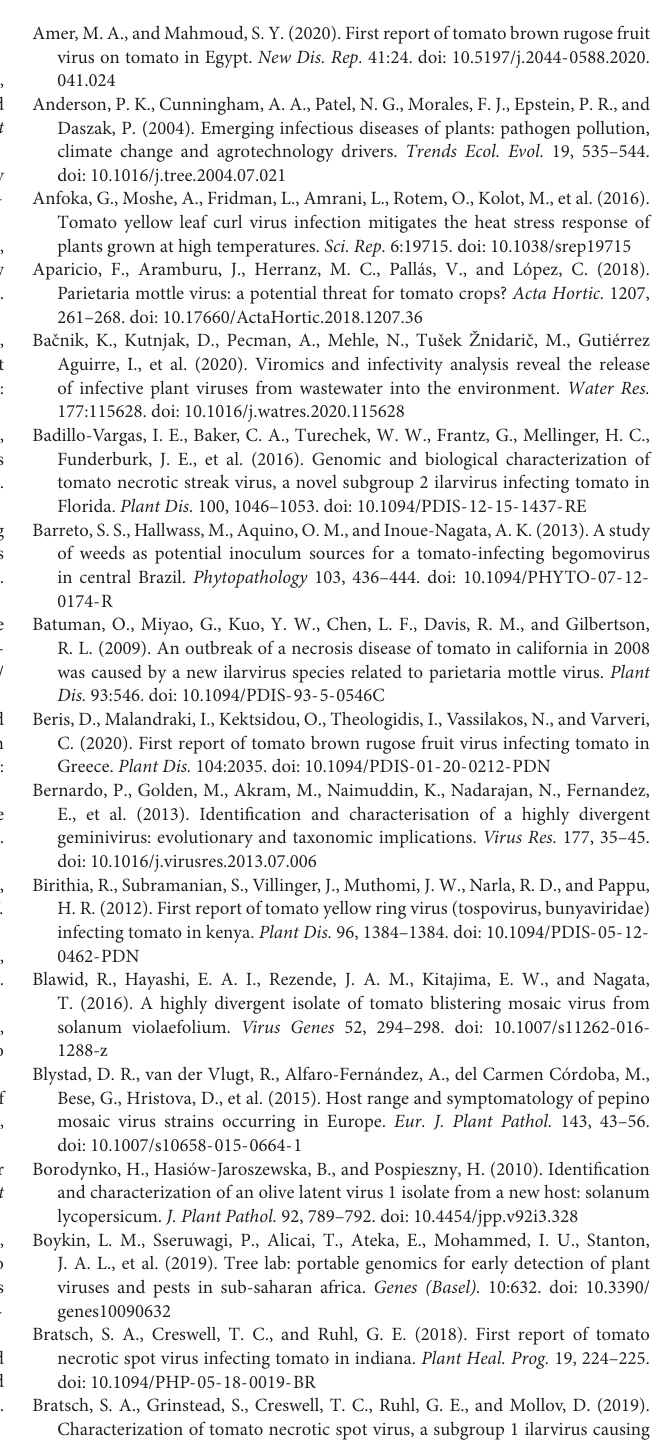
Supplementary Table 2 | Summary list of all viruses with tomato indicated as host based on review of literature and different